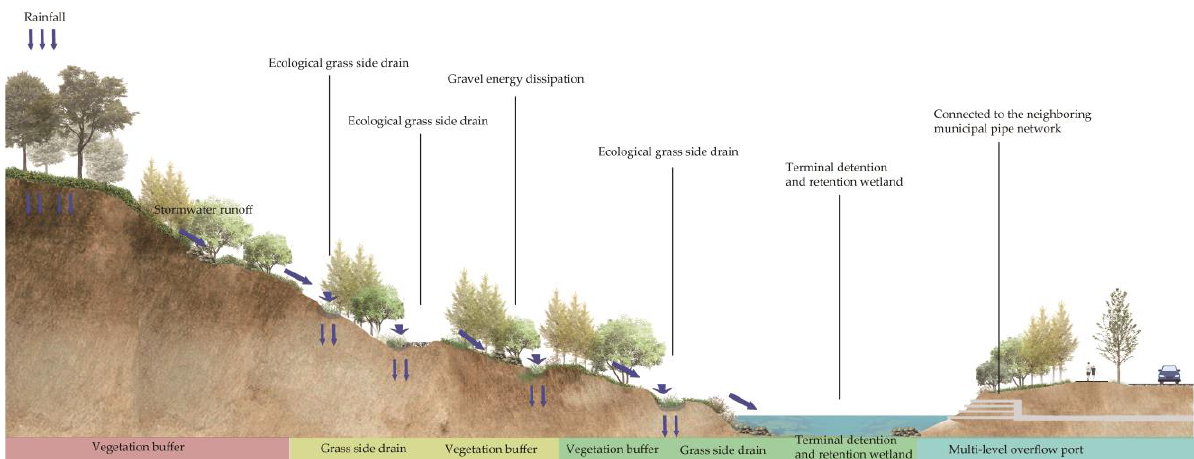
Figure 7. Schematic diagram of LID Scheme T.